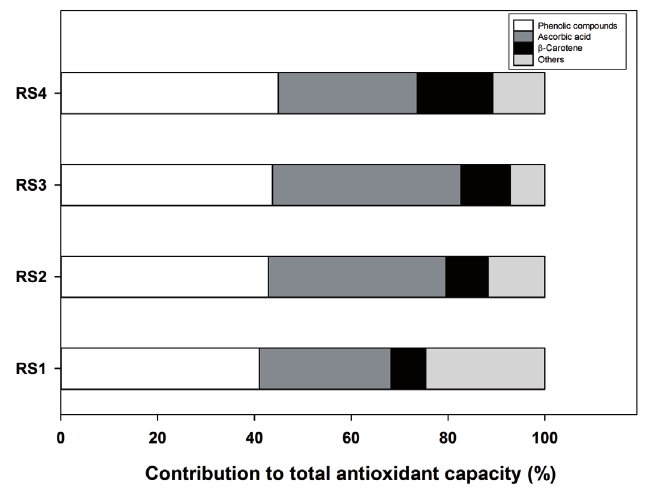
Fig. 4: Contribution of bioactive compounds to total antioxidant capacity of pineapple cv. Esmeralda at four ripening stages (RS). Data was cal- culated with the DPPH assay, using Equation